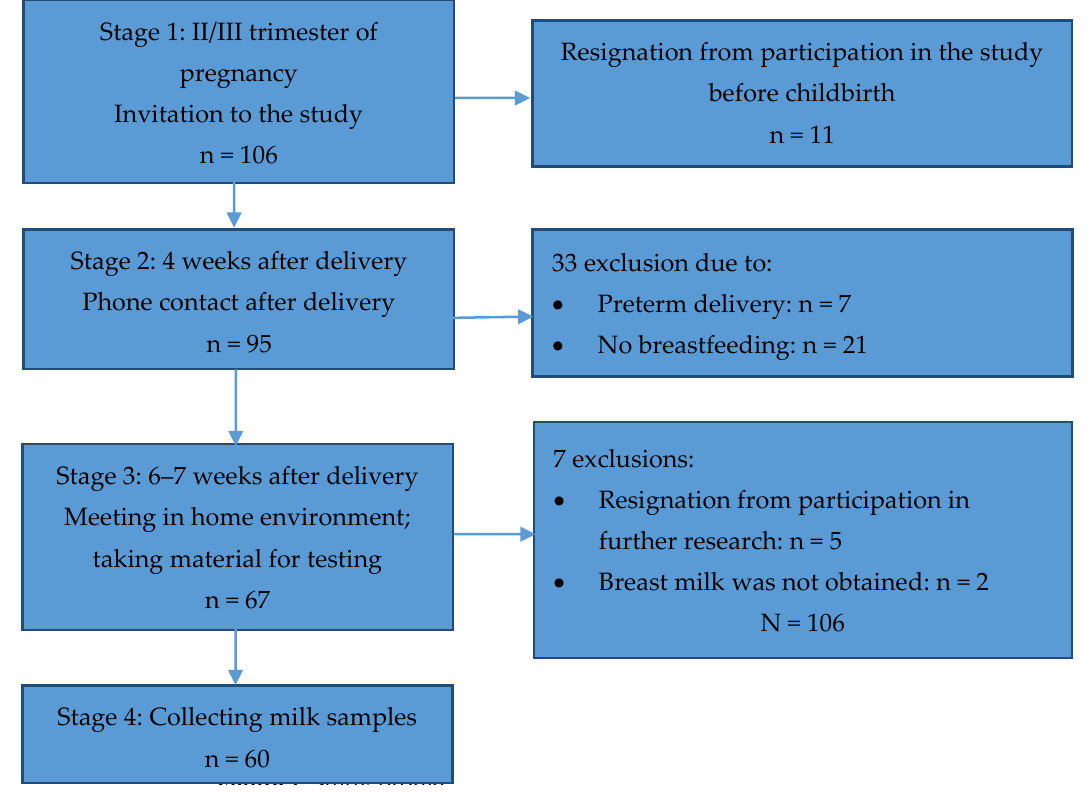
Figure 1. Study profile.